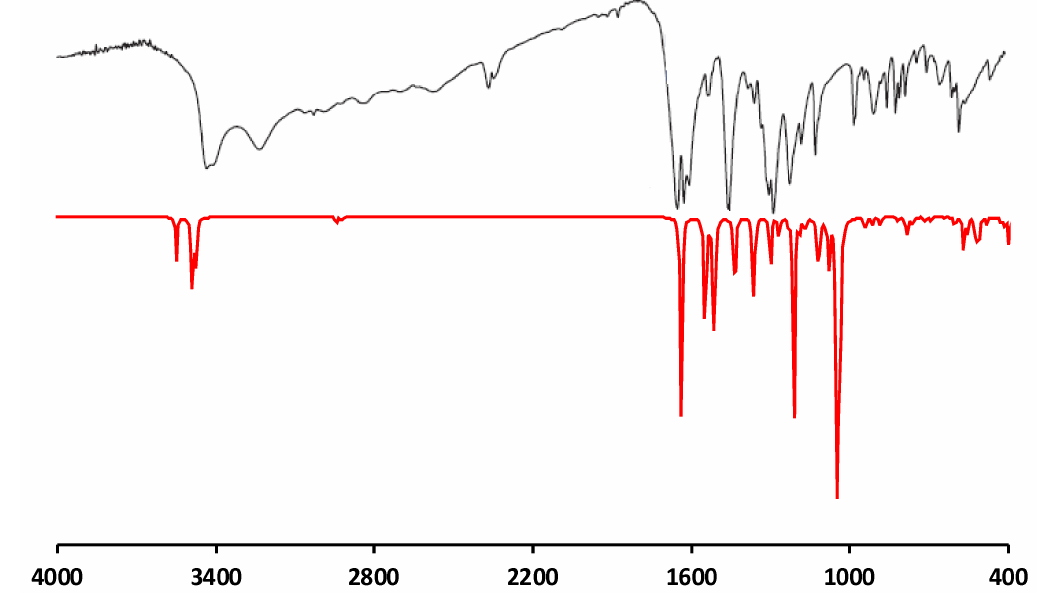
Figure 2. Experimental ( Ś WISŁOCKA , 2013) (up) and calculated (bottom) IR spectrum of caffeic acid.